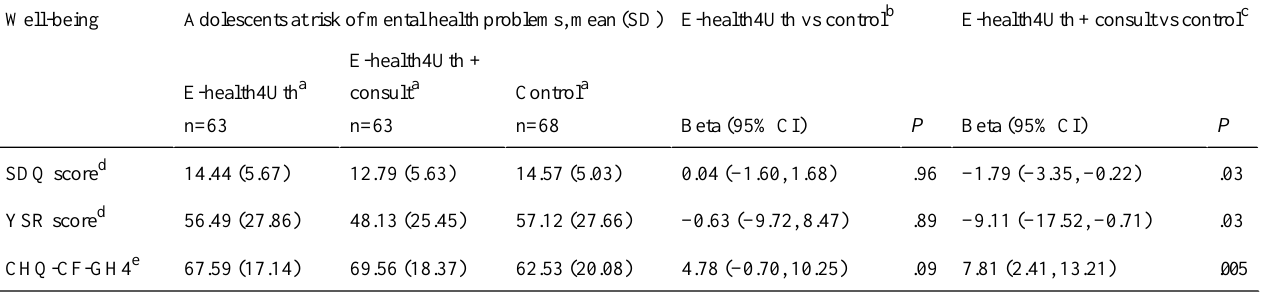
Table 3. Follow-up well-being of adolescents who were at risk of mental health problems at baseline and the effects of the interventions on well-being, with the control group as reference